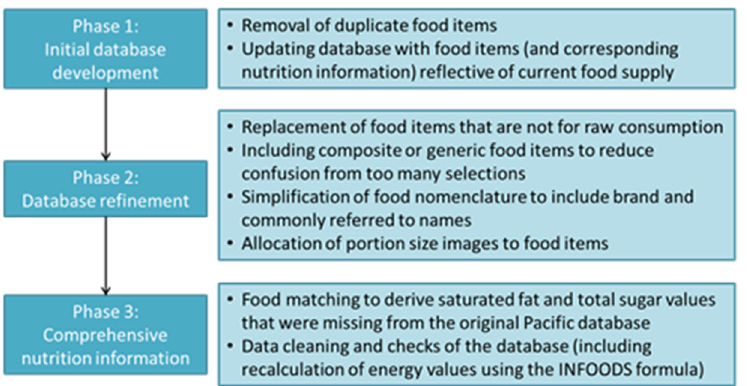
Figure 2. Phases in the development of the New Caledonian food composition database to support the iRecall.24 app.